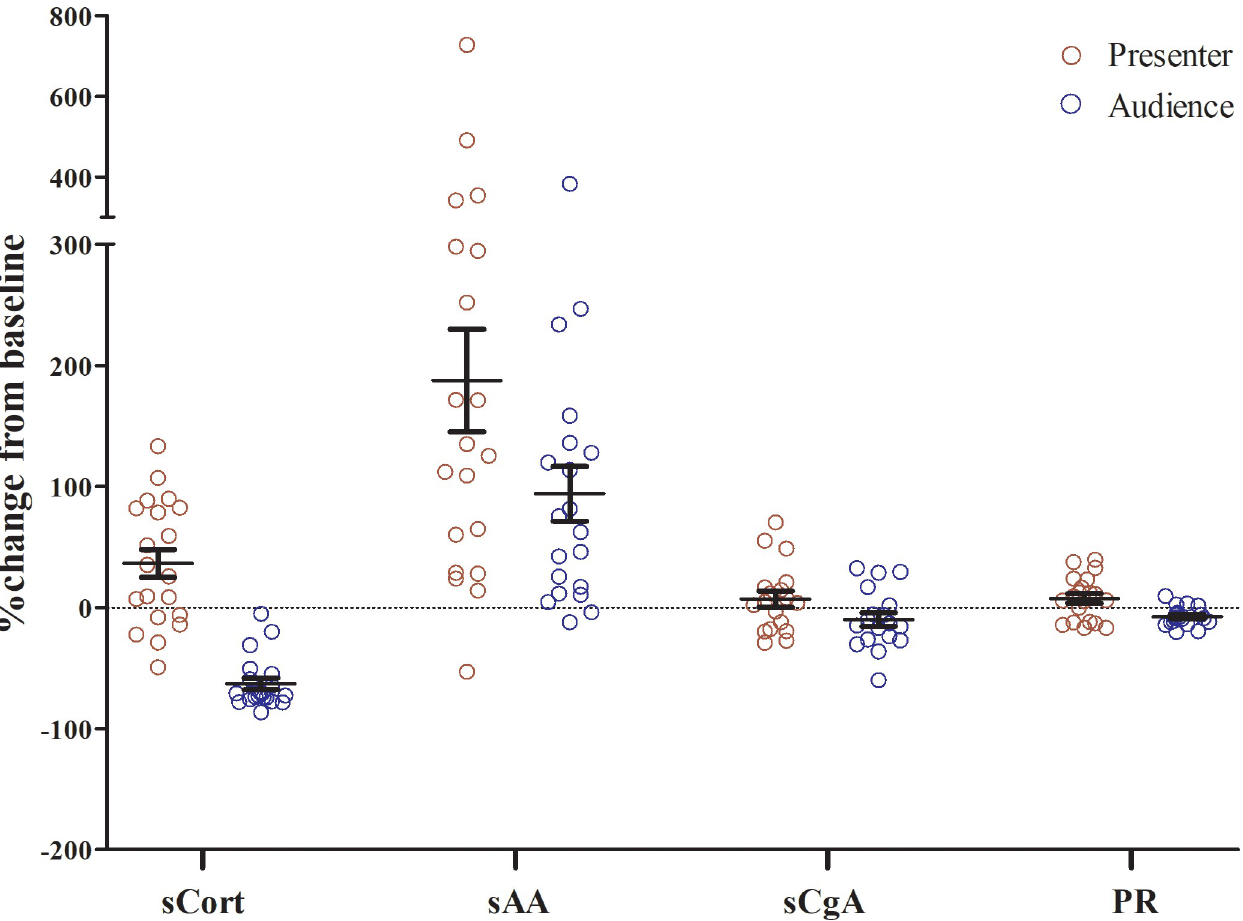
Fig 2. The percentage change of the salivary biomarkers and pulse rate from baseline. Data were presented as mean ± SEM.